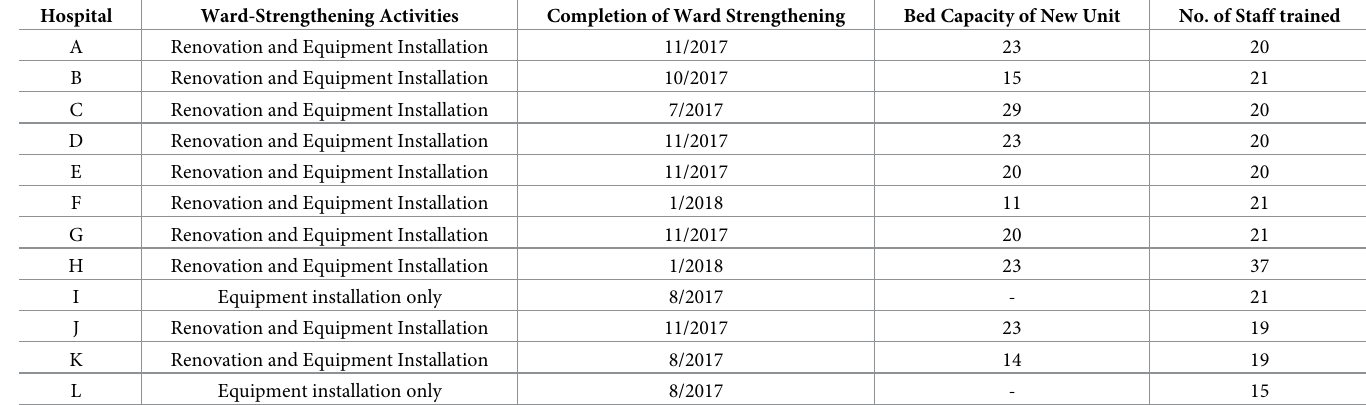
Table 2. Summary of renovations by facility for ward-strengthening program at district-level hospitals in Malawi